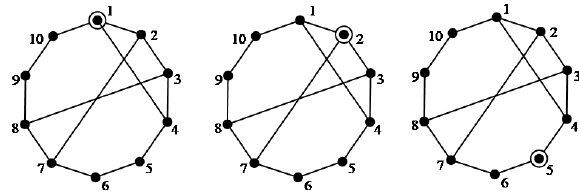
Figure 4. Non-isomorphic inversions derived from Fig. 3.